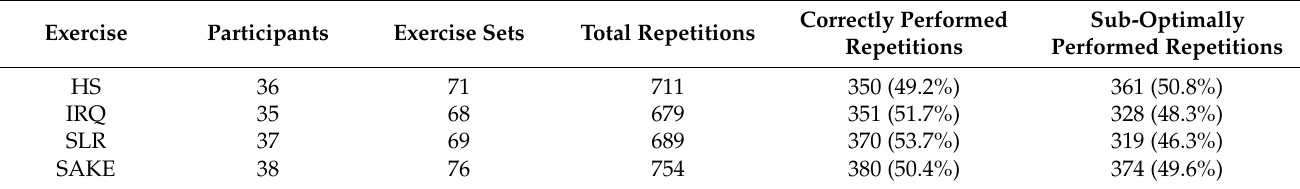
Table 2. Characteristics of the classification training